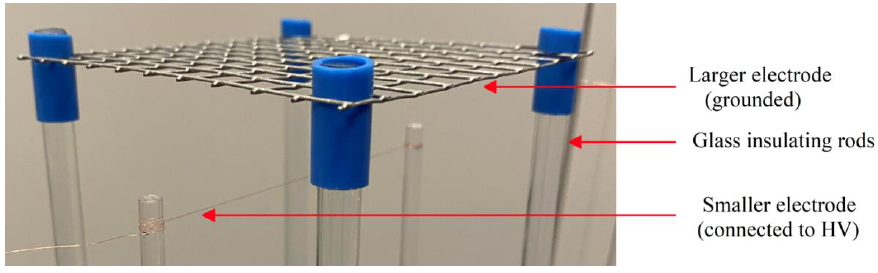
Figure 1. Image of the system of asymmetrical electrodes.